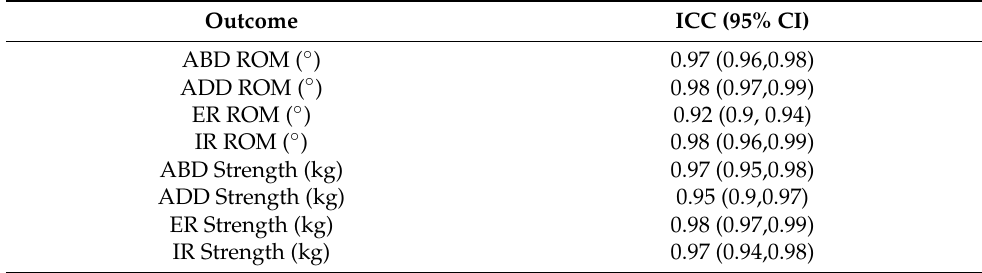
Table 1. Test–retest reliability of the study